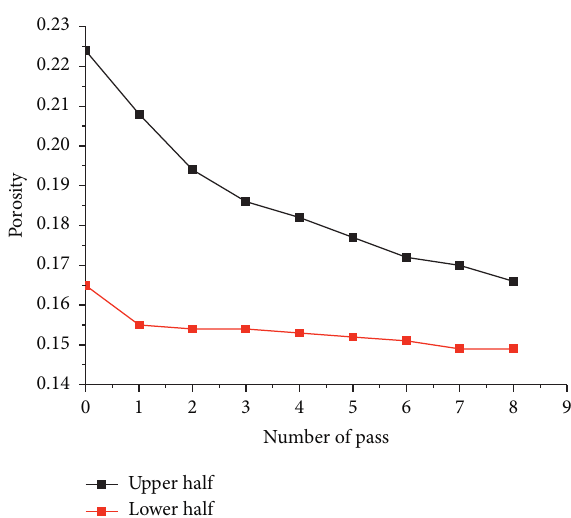
Figure 18: Porosity of the upper and lower half during vibratory roller compaction.